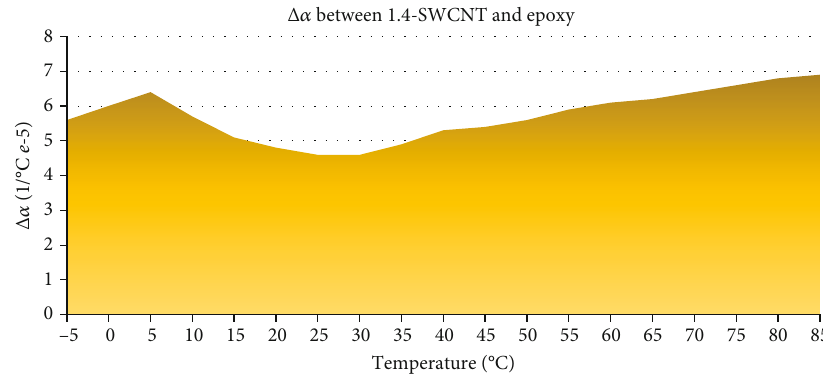
Figure 5: Mismatches between the CTEs of 1.4-SWCNT and epoxy ( Δα ) at the temperature range of -5 to 85 ° C within the 1.4-SWCNTE.